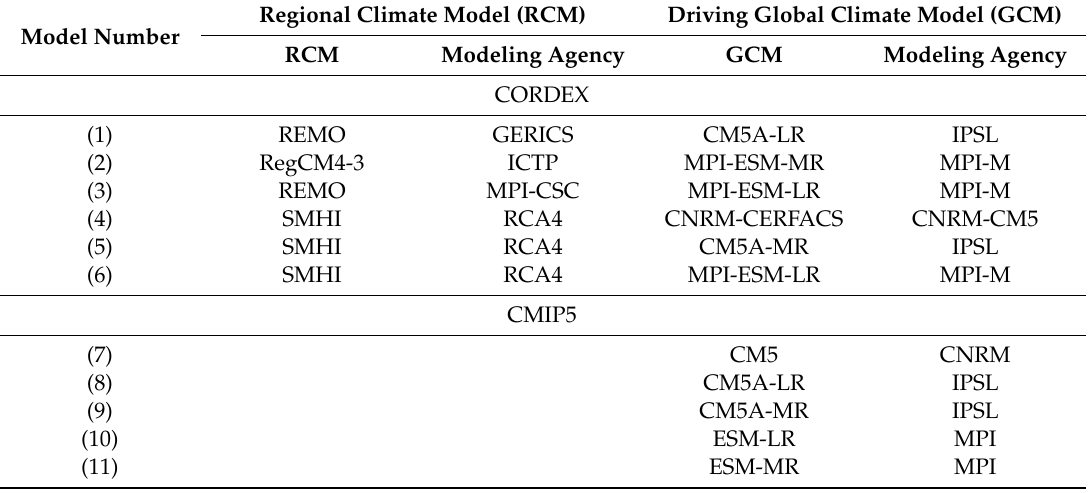
Table 1. Selected